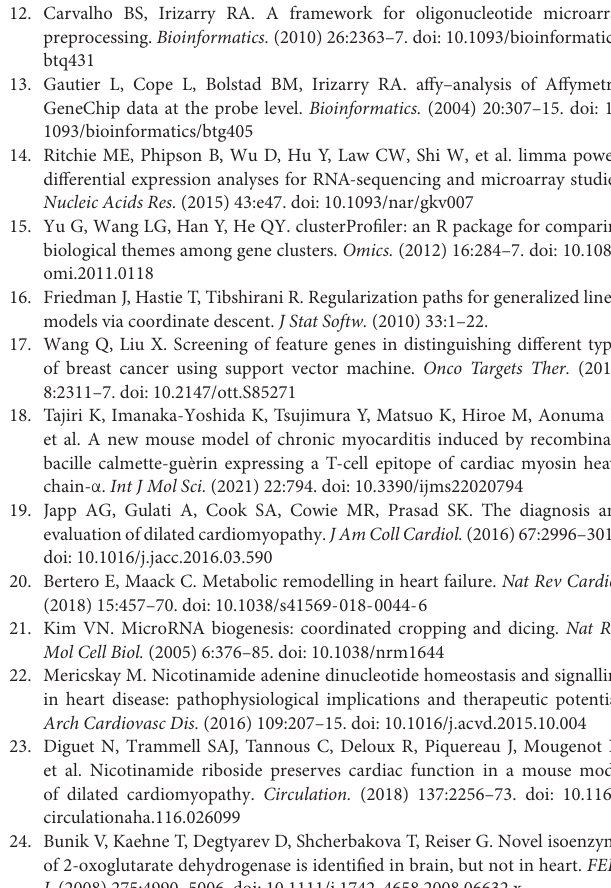
Supplementary Figure 1 | Validation of expression level of key genes. The expression of the key metabolism-related genes in the GSE5406